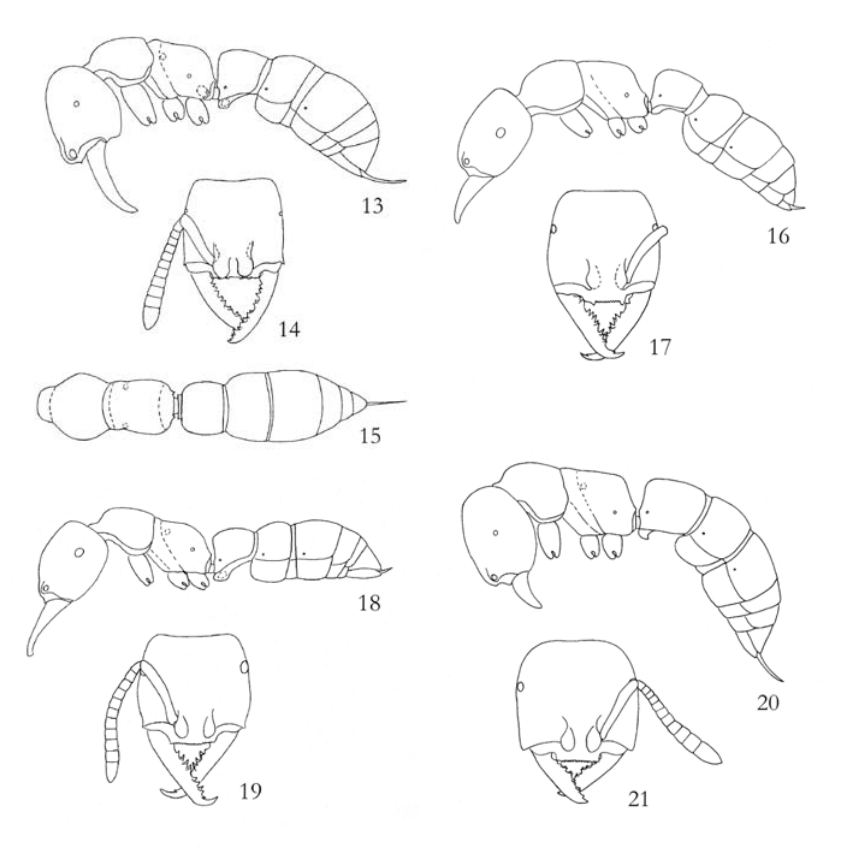
Figs. 13-21. 13-15: Worker of Amblyopone kangba sp. nov.; 13. Head and body in profile view; 14. Head in full-face view; 15. Body in dorsal view. 16-17: Worker of Amblyopone bellii Forel; 16. Head and body in profile view; 17. Head in full-face view. (Drawn from Antweb images). 18-19: Worker of Amblyopone reclinata Mayr; 18. Head and body in profile view; 19. Head in full-face view. (Drawn from Antweb images). 20-21: Worker of Amblyopone bruni (Forel); 20. Head and body in profile view; 21. Head in full-face view. (Drawn from Antweb